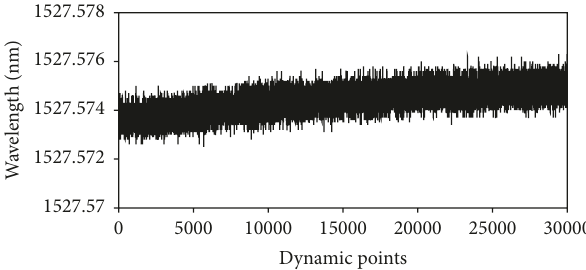
Figure 20: Information of 30000 collected wavelengths from 3:00 pm on 9 April 2015.